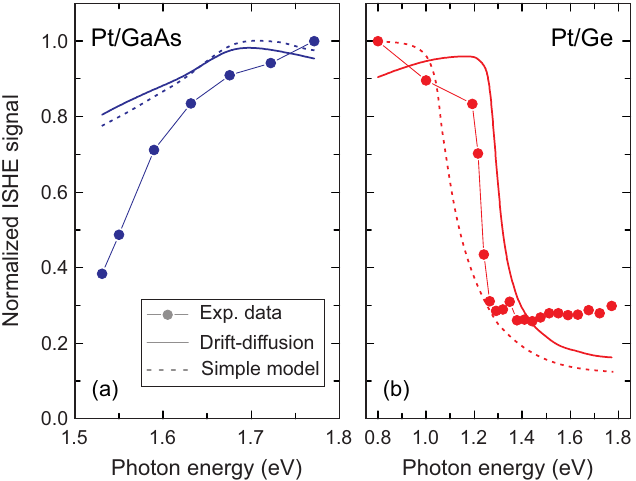
Figure 4. Comparison between the measured ISHE signal (obtained at θ = 65 ◦ and φ = 0) and the calculated spin current. The full lines correspond to the result of the drift-diffusion model, while the dashed lines to the simplified model assuming that all the spins generated within a distance L s from the metal/semiconductor interface are injected in the Pt contact (see text). ( a ) Pt/GaAs ( τ s = 10 − 11 s); ( b ) Pt/Ge ( τ s = 10 − 9